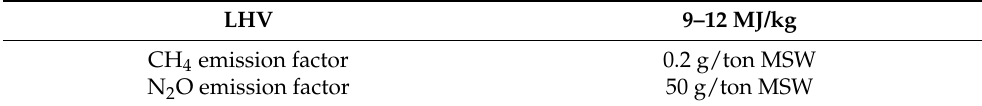
Table 14. The emission factor and average heating value of MSW